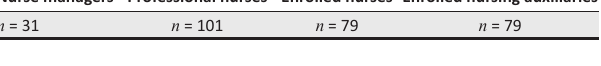
TABLE 2: Resilience scale: Maximum and minimum scores, mean and standard deviation of the respondents Variable